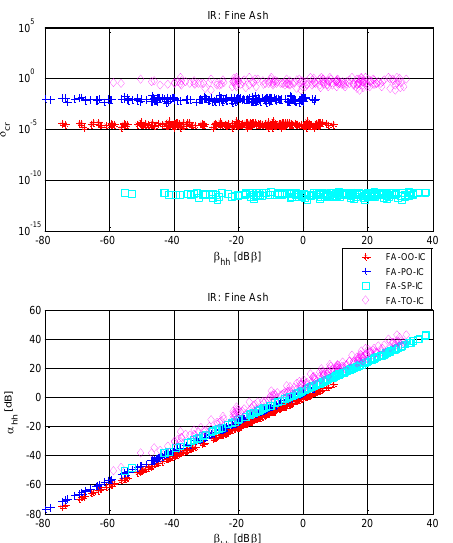
Figure 1b: Same as in the Figure 1a panels, but for the zenith lidar copolar backscatter coefficient  hh (1064nm), linear cross- polarization ratio δ cr (1064nm), and extinction coefficient  hh (1064nm) with relative humidity ranging between 30 and